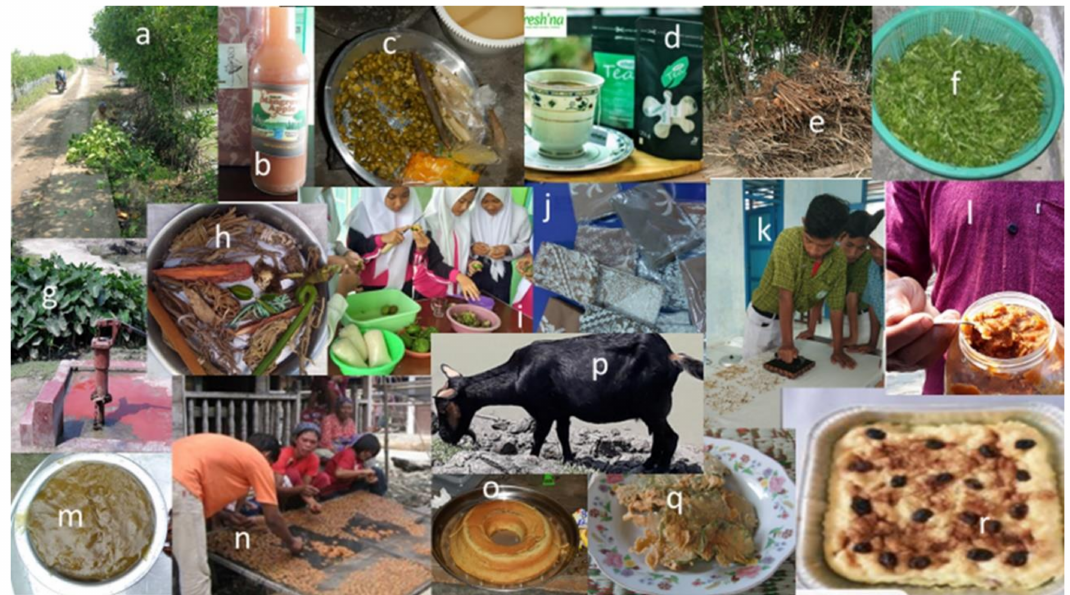
Figure 2. Examples of sustainable mangrove-based non-timber forest products (NTFPs), excluding fisheries: ( a ) Rhizophora mucronata fodder for livestock, Java, ( b ) bottled juice from Sonneratia caseolaris , Java, ( c ) food from Avicennia marina and Bruguiera gymnorhiza , ( d ) tea from Acrostichum illicifolia , Java, ( e ) sustainable firewood from R. mucronata , Java, ( f ) A. illicifolia leaf processing for tea or chips, ( g ) saline vegetable patch Colocasia esculenta , Bangladesh, ( h ) mix of mangrove medicinals including R. mucronata root, Xylocarpus mekongensis bark, Vitex simplex vine, Thypha dominguensis stalks and ear, Khulna, Bangladesh, ( i ) girls learning to make dessert from S. caseolaris , Java, ( j ) selection of handmade batik textile products, Java, ( k ) youths learning the batik techniques, ( l ) syrup from Phoenix sylvestris , Paikgacha, Bangladesh, ( m ) chutney from Sonneratia apetala , Khulna, Bangladesh, ( n ) A. illicifolia chips, Java, ( o ) A. marina cake, Java, ( p ) small saline-adapted Black Bengal goat, Capra hircus , ( q ) Avicennia leaf chips, Timbulsloko, Java, ( r ) Nypa fruticosa cake, Java. Photo credits: A.O.D.: a, e, g, j, l, p, q; R.F.: d, f, n, r; Kuswantoro: b, i, k; E.D.: c, o; M.U.A.: n,